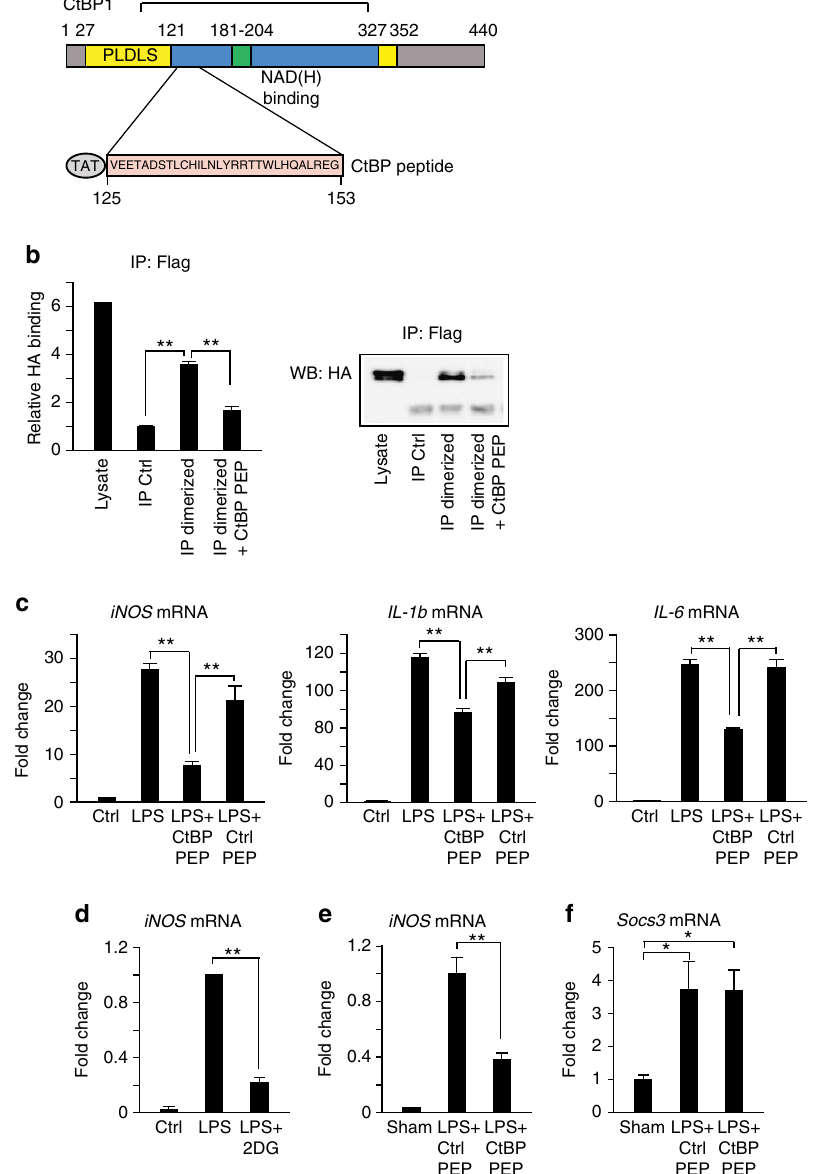
Fig. 7 Direct inhibition of CtBP dimerization blocks LPS-induced pro-in fl ammatory gene expression. a Schematic of CtBP1 protein showing functional domains and alignment with the CtBP peptide used to block CtBP dimerization. PLDLS indicates substrate binding domain. The CtBP blocking peptide includes an N-terminal TAT sequence for cellular internalization. b Immunoprecipitation assay showing ability of CtBP peptide (50 µ m) to block dimerization of tagged CtBP proteins incubated with 10 mM lactate + 10 µ m NADH. Full length immunoblots are shown in Supplementary Fig. 3. Immunoprecipitation was performed with anti-Flag antibody, and CtBP1-Flag/CtBP1-HA heterodimers were detected by western blots using anti-HA antibody. Lysate control lane = 5% of input used in immunoprecipitated samples. n = 4. ** p < 0.01. c CtBP peptide (5 µ m) blocks LPS-induced mRNA expression of pro-in fl ammatory genes (iNOS, IL-1b and IL-6) in cultured primary microglia. Ctrl PEP = control peptide. n ≥ 3; ** p < 0.01. d 2DG blocks LPS-induced iNOS gene expression in microglia isolated from mice after LPS (8 µ g) injection into striatum. n = 3 – 5 per group. ** p < 0.01. e , f CtBP peptide blocks LPS-induced iNOS expression but not Socs3 expression in brain microglia. n = 4 per group. ** p < 0.01. Error bars show